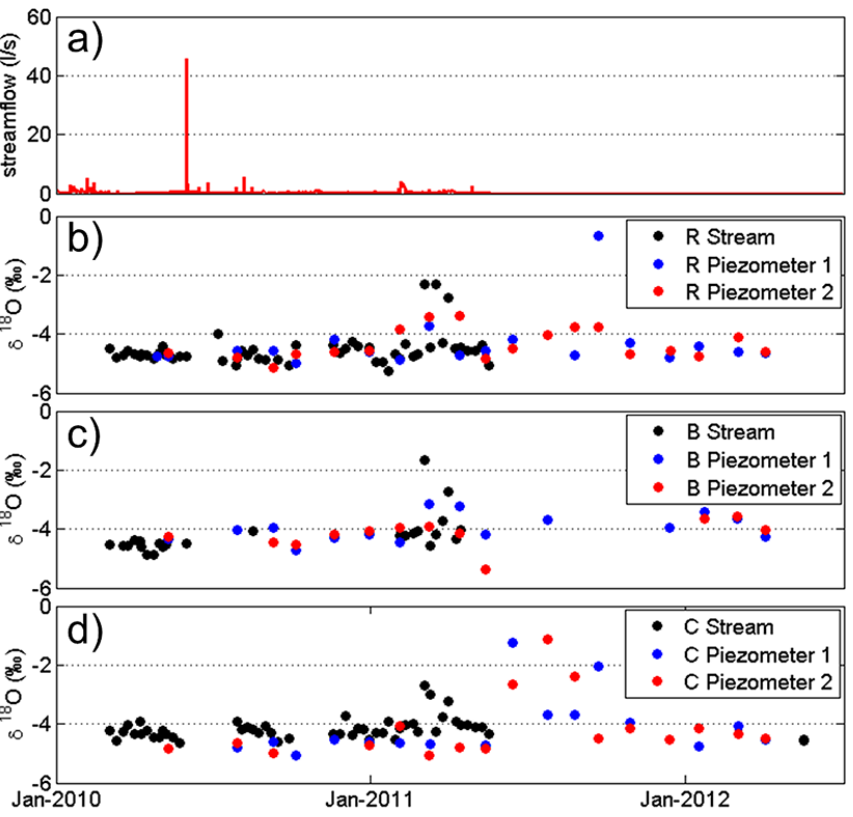
Figure 6. Temporal dynamics of the streamflow exemplified by the R stream (a) and of 18 O in riparian groundwater and the stream outlet for the R (b) , B (c) , and C (d) watersheds.